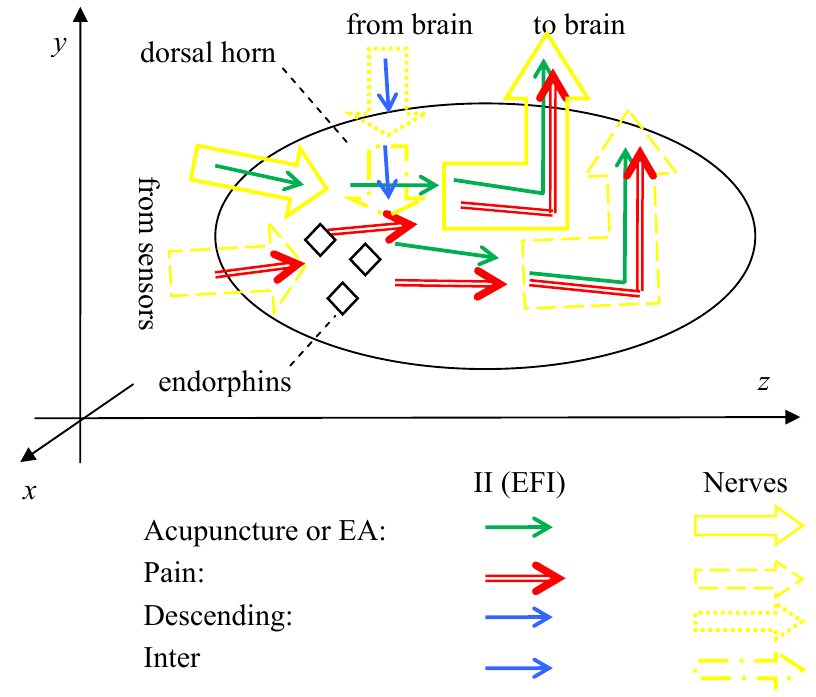
Figure 3. Our model of the nervous II (EFI) of acupuncture (or EA), pain, descending and inter in a spinal cord. Neuronal transmitters, endorphins, are also included.